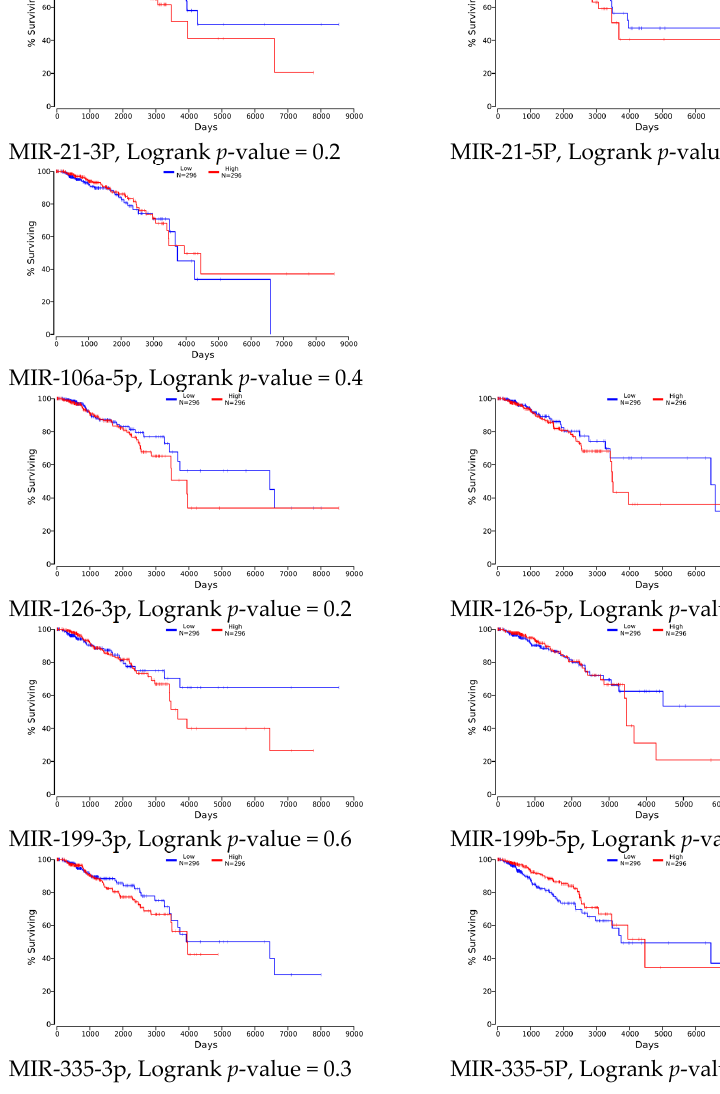
Figure 4. Association between studied miRNAs levels and patients’ survival estimated with the use of miRNA-seq data submitted in TCGA. Lower and upper percentile were set at 30; high and low expression was estimated in 296 cases each group; data analyzed in [40].